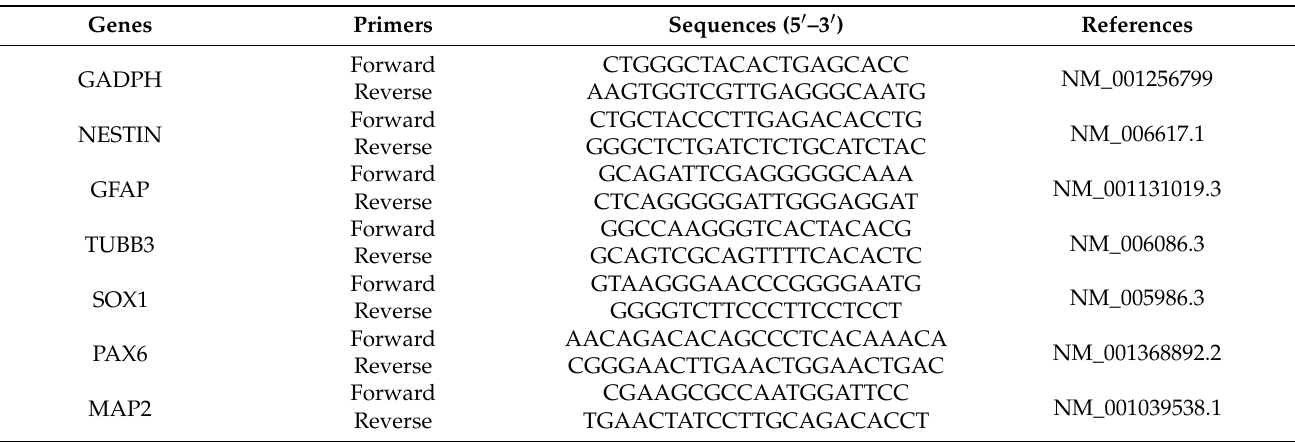
Table 2. Forward and reverse primers for qRT–PCR.